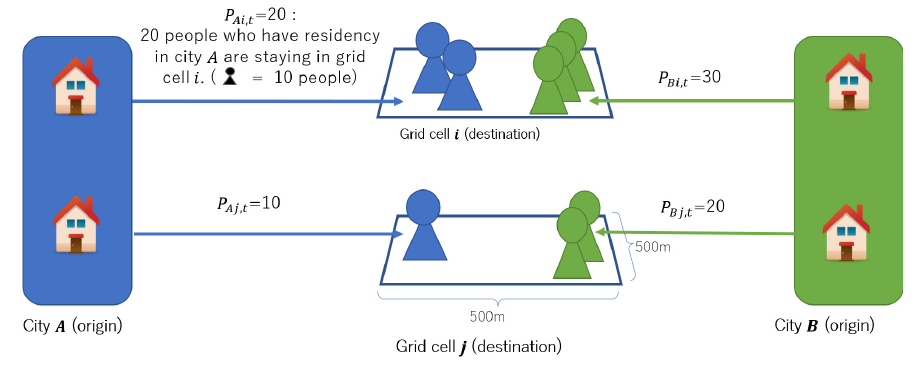
Fig 2. Outline of mobile spatial statistics